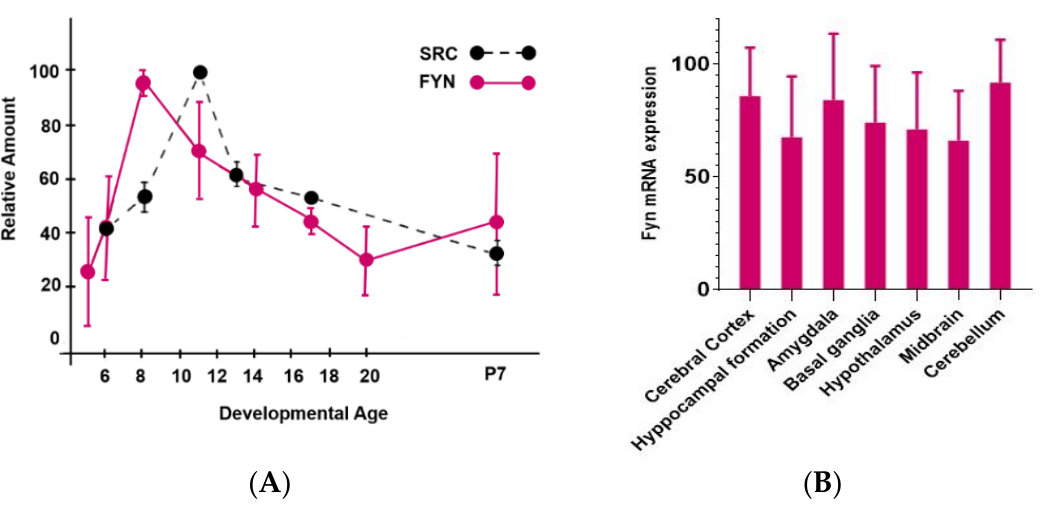
Figure 2. Fyn expression in human brain. ( A ) Fyn mRNA expression during development (6–20 refers to embryonic days; P7 = 7 days post-hatch). Adapted from Bixby et al. (1993) [58]. ( B ) Fyn human expression in the different areas of adult brain (data extracted from ATLAS).